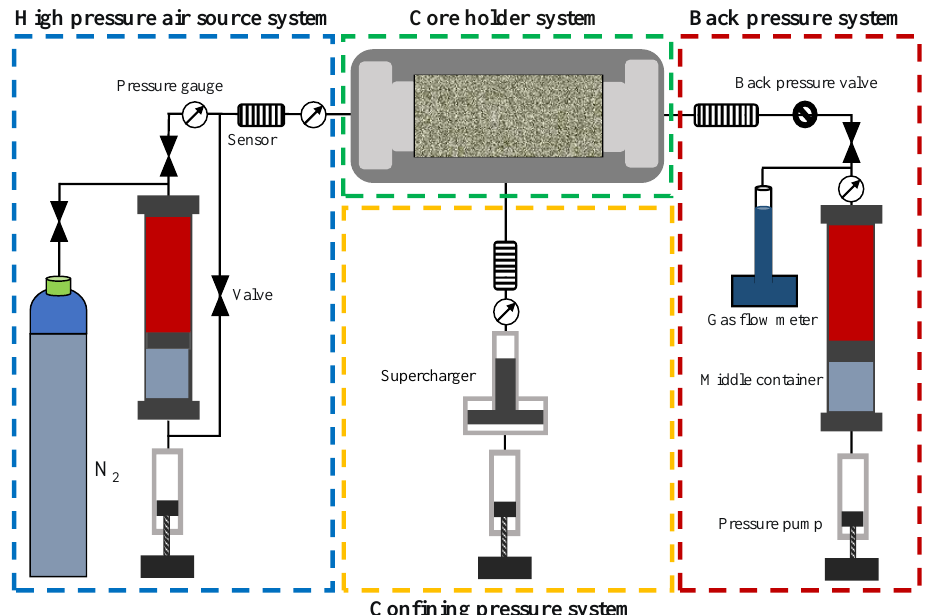
Figure 2. Structure diagram of experimental equipment.